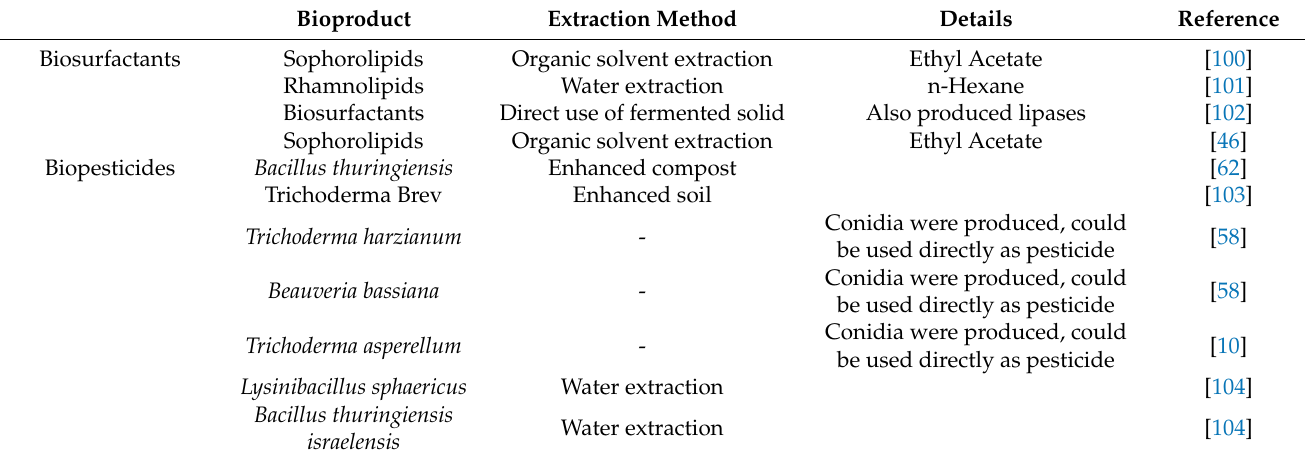
Table 2. Compilation of extraction methods for different bioproducts produced by